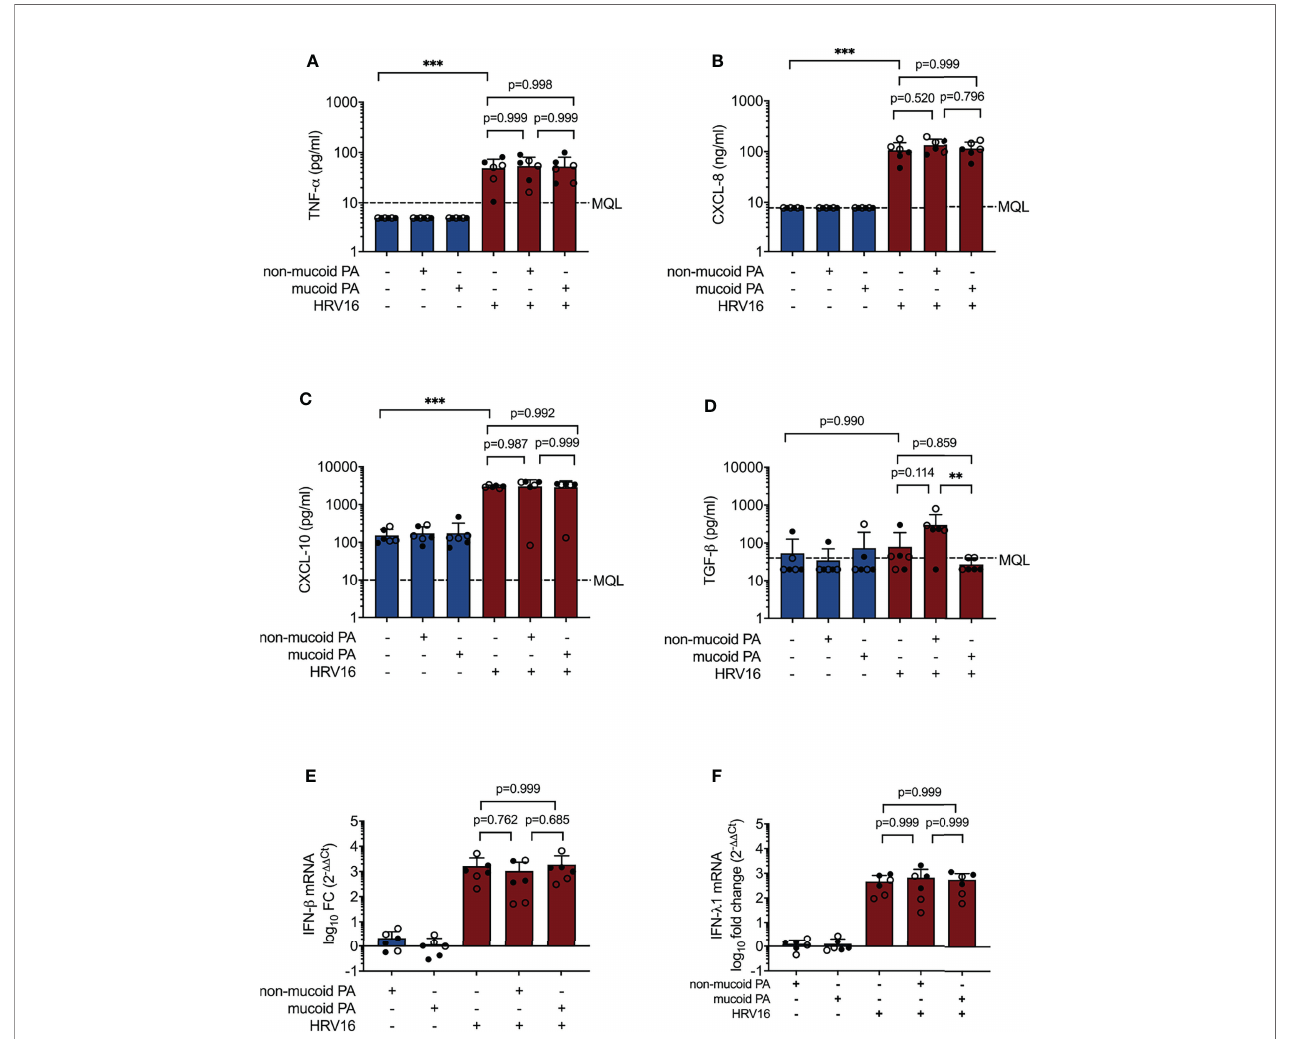
FIGURE 2 | Cytokine production in differentiated bronchial epithelial cells co-infected with P. aeruginosa (PA) and human rhinovirus 16 (HRV16). (A) TNF a protein concentrations in basal media (B) CXCL-8 protein concentrations in basal media (C) CXCL-10 protein concentrations in basal media (D) TGF- b protein concentrations in basal media (E) IFN- b mRNA levels (F) IFN- l mRNA levels. MQL, Minimum quanti fi able level. Cell type: ○ Emphysema ● Cystic fi brosis. Data were obtained in six independent experiments, each performed with cells derived from a different donor. *p ≤ 0.05, **p ≤ 0.01, ***p ≤